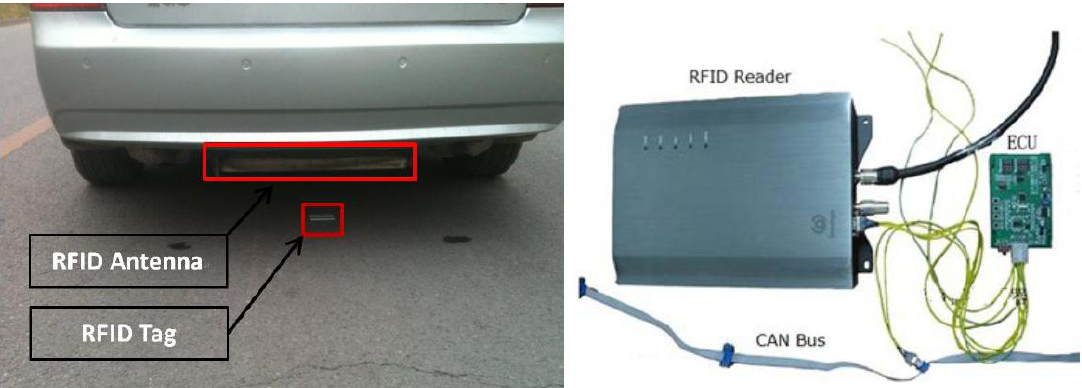
Figure 2. RFID tag, antenna, reader, and controller unit.